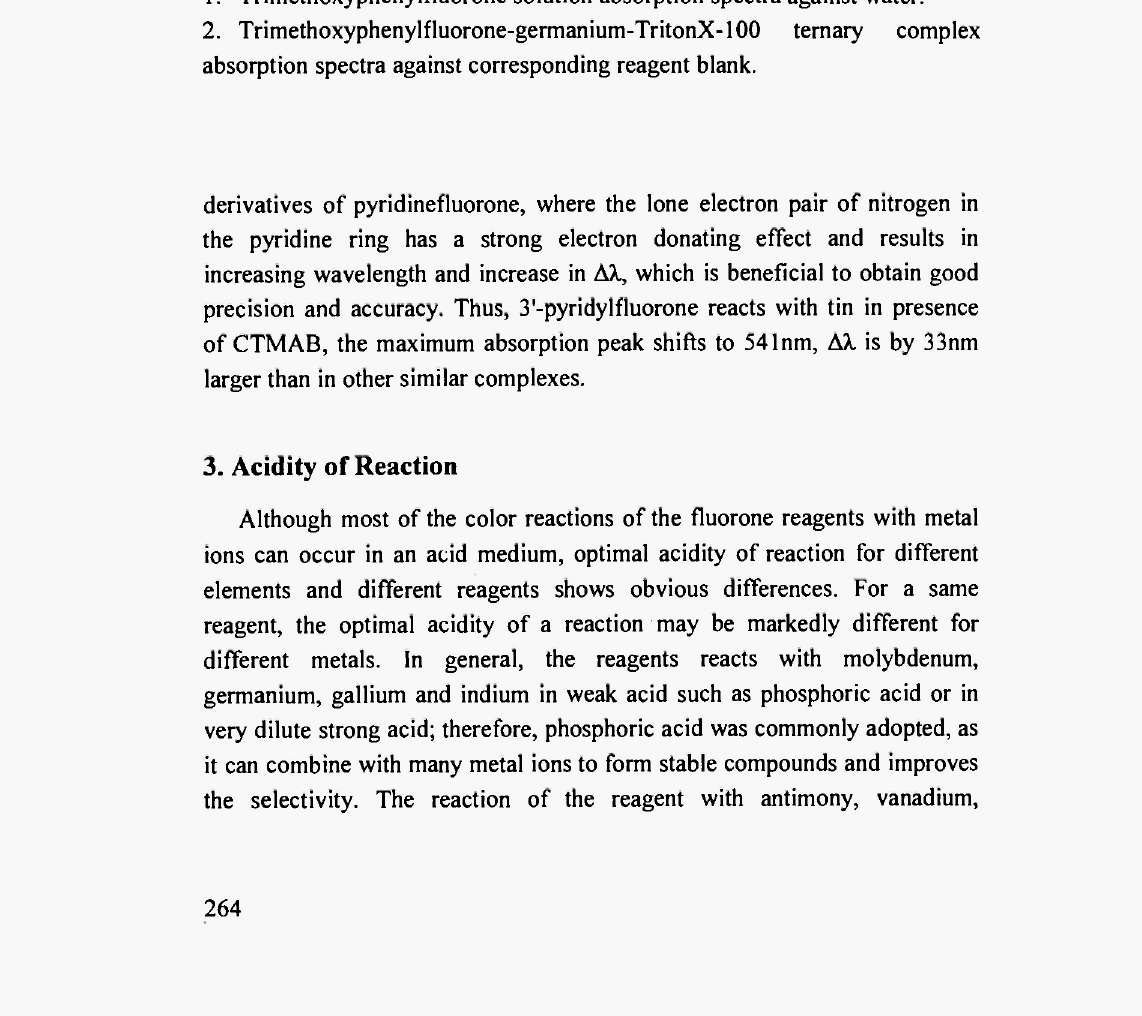
Fig. 4: The absorption spectra 1. Trimethoxyphenylfluorone solution absorption spectra against water. 2. Trimethoxyphenylfluorone-germanium-TritonX-100